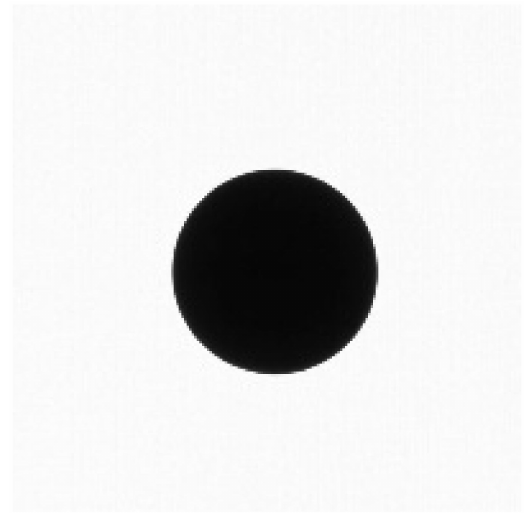
Figure 10. Images of the 17-mm standard gauge